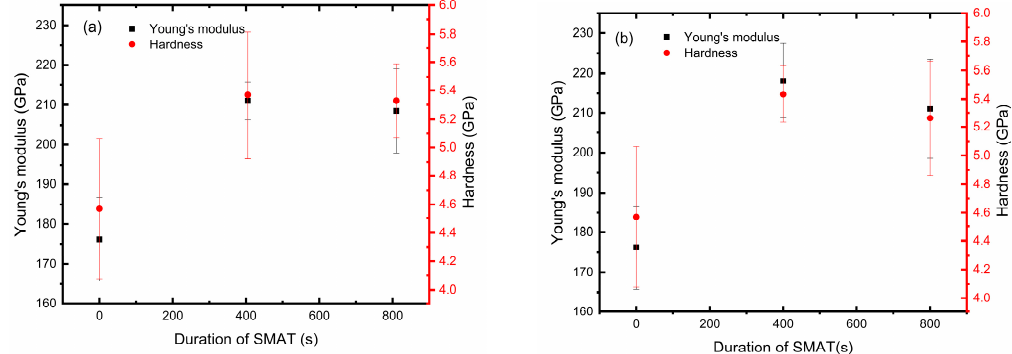
Figure 8 . Mean grain size and micro-strain evolution as a function of SMAT duration; ( a ) SMATed with an amplitude of 15 µm; ( b ) SMATed with an amplitude of 25 µm.